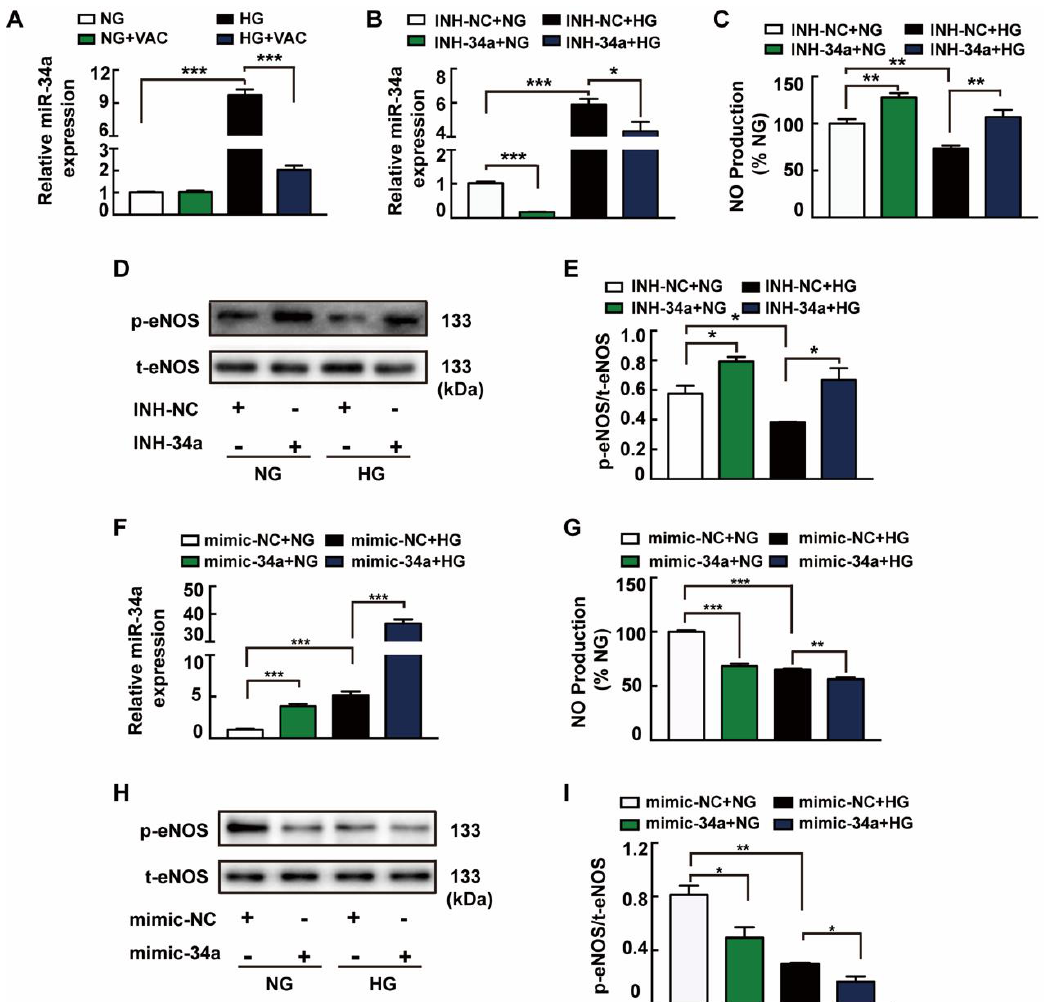
Figure 3. The role of miRNA-34a in VAC-promoting NO production. HMEC-1 cells were incubated with vaccarin (5 μM) for 12 h, or miRNA-34a inhibitor or mimic for 6 h and then stimulated with 35 mM HG for 48 h. ( A ) Effects of vaccarin (5 μM) on the miRNA-34a expression in response to HG. Effects of inhibition of miRNA-34a on HG-stimulated miRNA-34a expression ( B ), NO generation ( C ), eNOS phosphorylation ( D and E ). Effects of miRNA-34a mimic on HG-stimulated miRNA-34a expression ( F ), NO generation ( G ), eNOS phosphorylation ( H and I ). n = 3 for each group in D, E, H and I; n = 5 for other groups. Values are mean ± SEM. * p < 0.05, ** p < 0.01, *** p < 0.001. NC, negative control; INH, inhibitor.